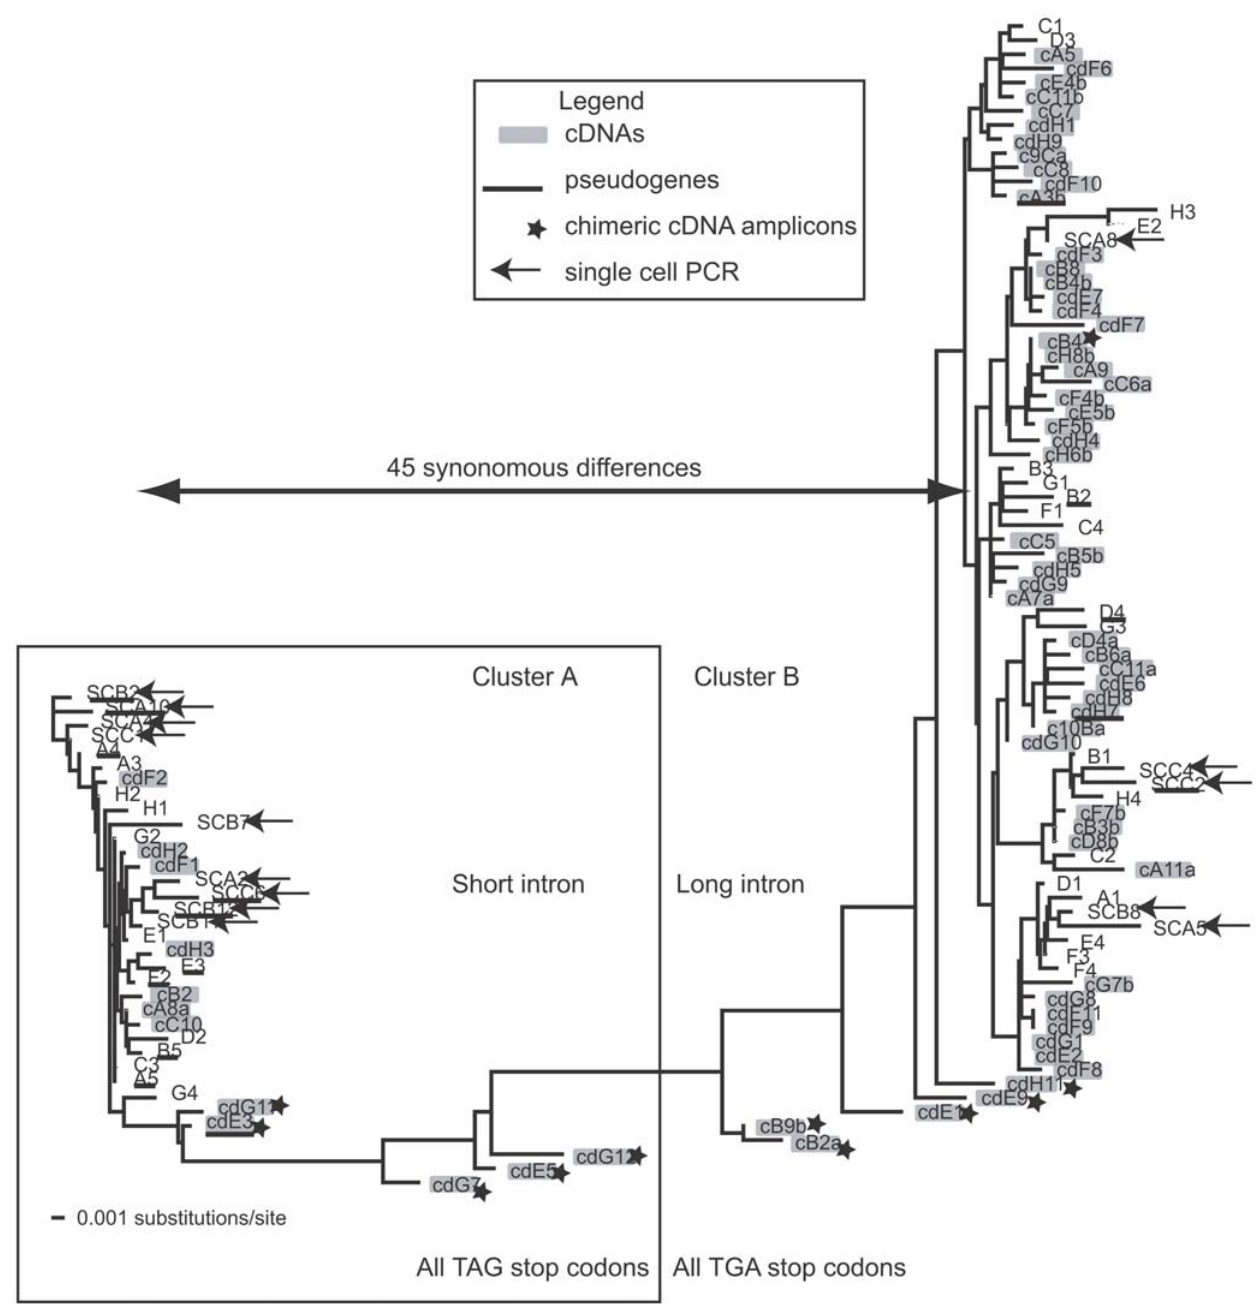
Figure 4. A distance tree using both genomic and expressed versions of the actin gene. The tree was based on an 800 base coding region common to all amplicons (see Figure 3). The two genomic clusters were cleanly divided based on 45 synonymous substitutions over 800 bases, with no intermediate sequences found in the genomic clones (exemplified by the stop codons in this figure). Other features such as intron sequence, and intergenic spacer sequence also sort the two genomic clusters. Multiple pseudogene versions were also found and are underlined. Expressed sequences are marked with colored boxes and were mostly drawn from a single cluster with several chimeric sequences having features of both genomic clusters (marked with a star).